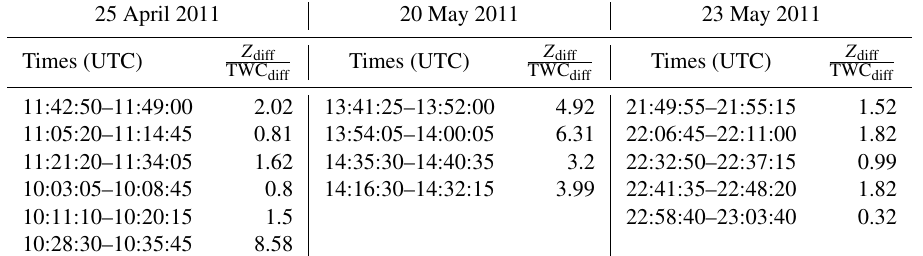
Table 2. List of constant-temperature flight legs and the ratio between Z diff and TWC diff valid at the ( a,b ) values that minimize χ 2 .